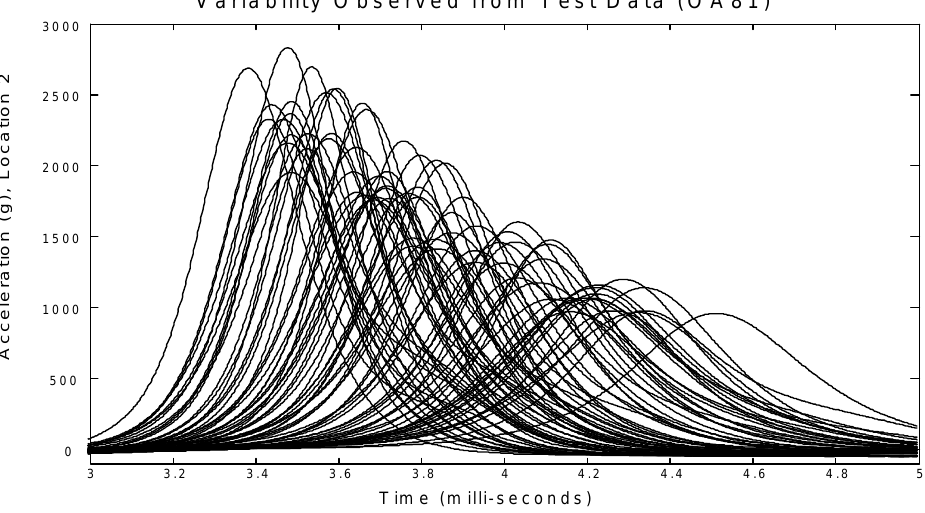
Fig. 7. FEA response variability, Accelerometer